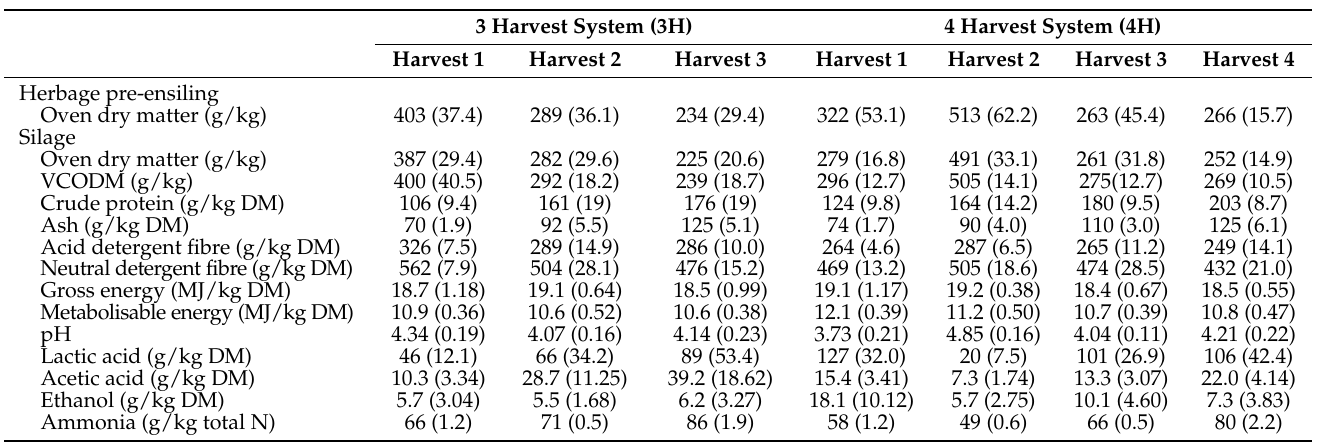
Table 2. Dry matter of herbage at ensiling, and the chemical composition (SD in parenthesis) of the resultant silage as produced within a three- (3H) or four-harvest (4H) system. 3 Harvest System